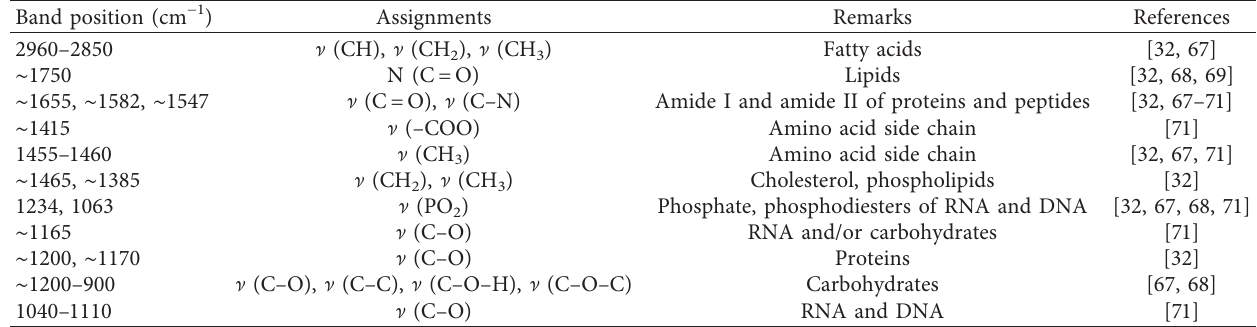
Table 1: Spectral band assignments for brain tumors for the FTIR models.